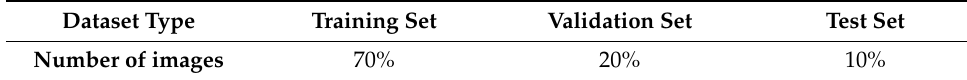
Table 3. The data set structure and number.